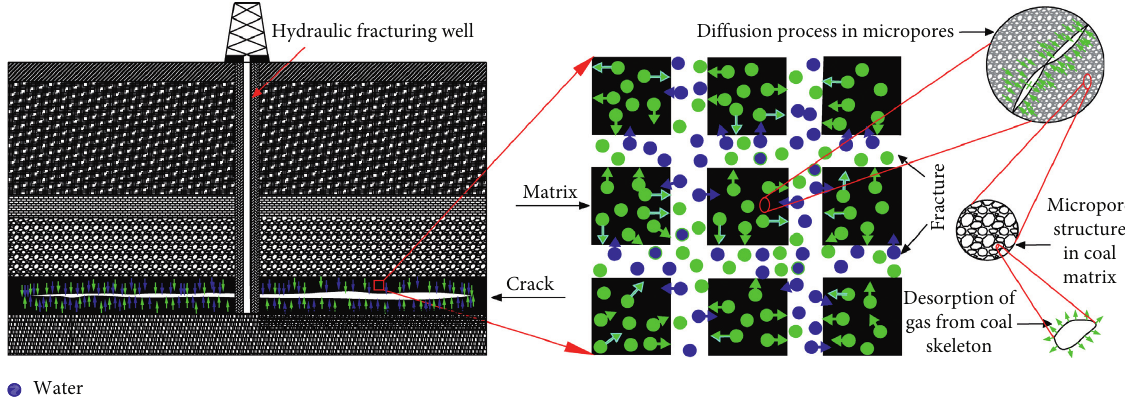
Figure 1: Schematic diagram of CBM exploitation